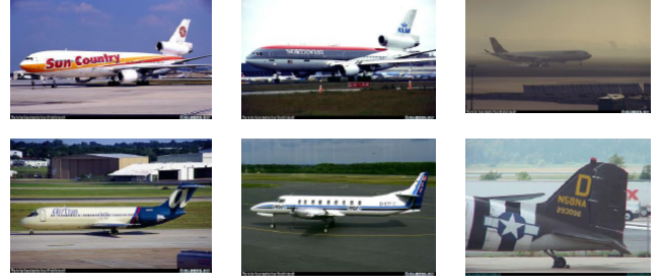
Figure 8. Sample images from the FGVC-Aircraft dataset.